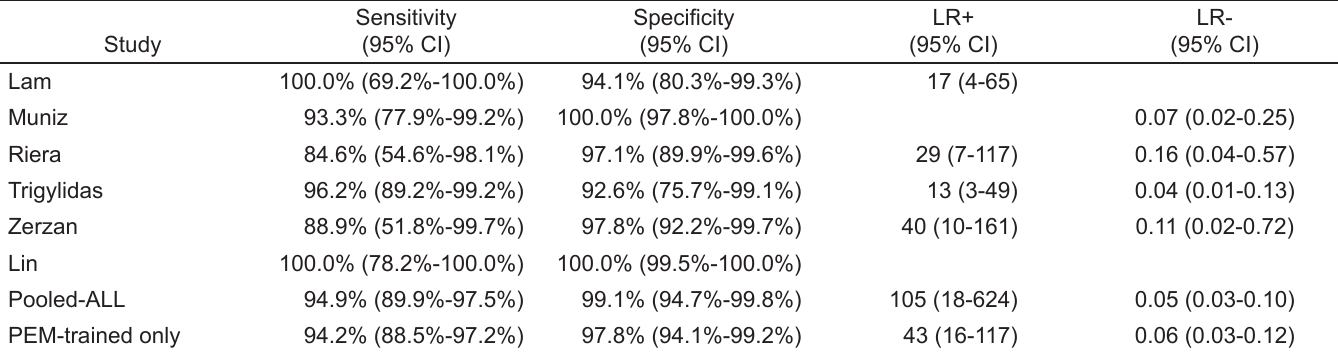
Table 2. Diagnostic accuracy data from included studies and pooled results.